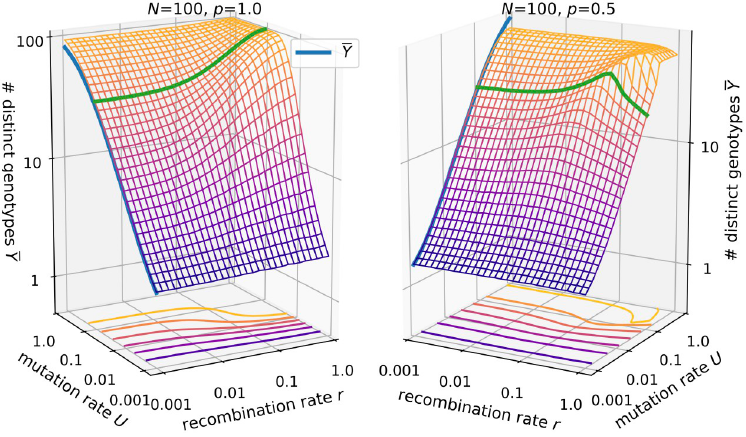
Fig 4. Number of distinct genotypes in the ism . Parameters are N = 100 and p = 1.0 (left panel) vs. p = 0.5 (right panel). The blue lines shows Eq 13, where θ is replaced by θ � for p � 1. The green line is drawn at U = 0.1.